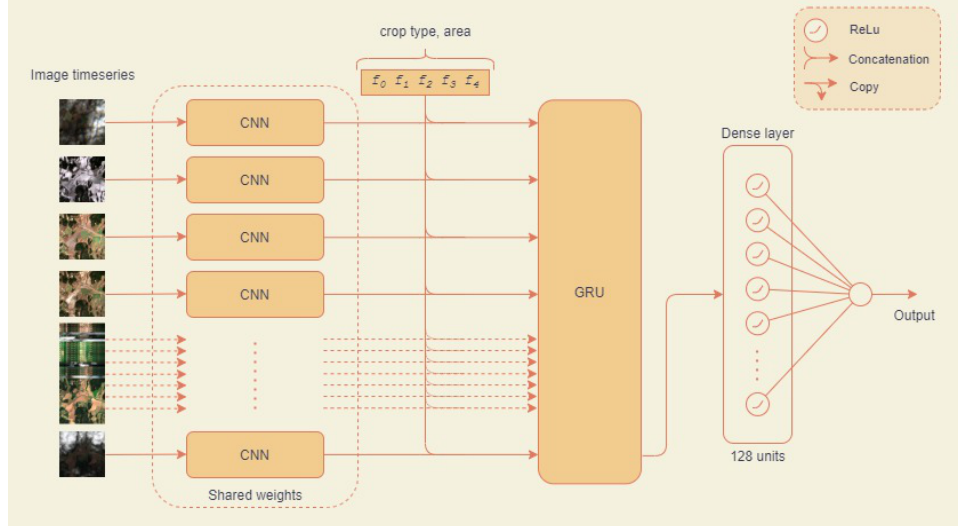
Figure 5. Initial experiment 2: multi-temporal CNN–RNN model